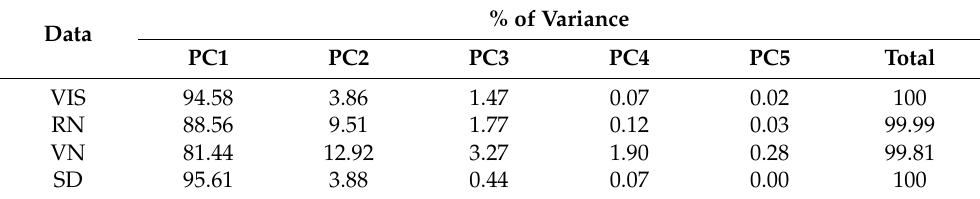
Table 3. The principal component analysis (PCA) results according to input data.